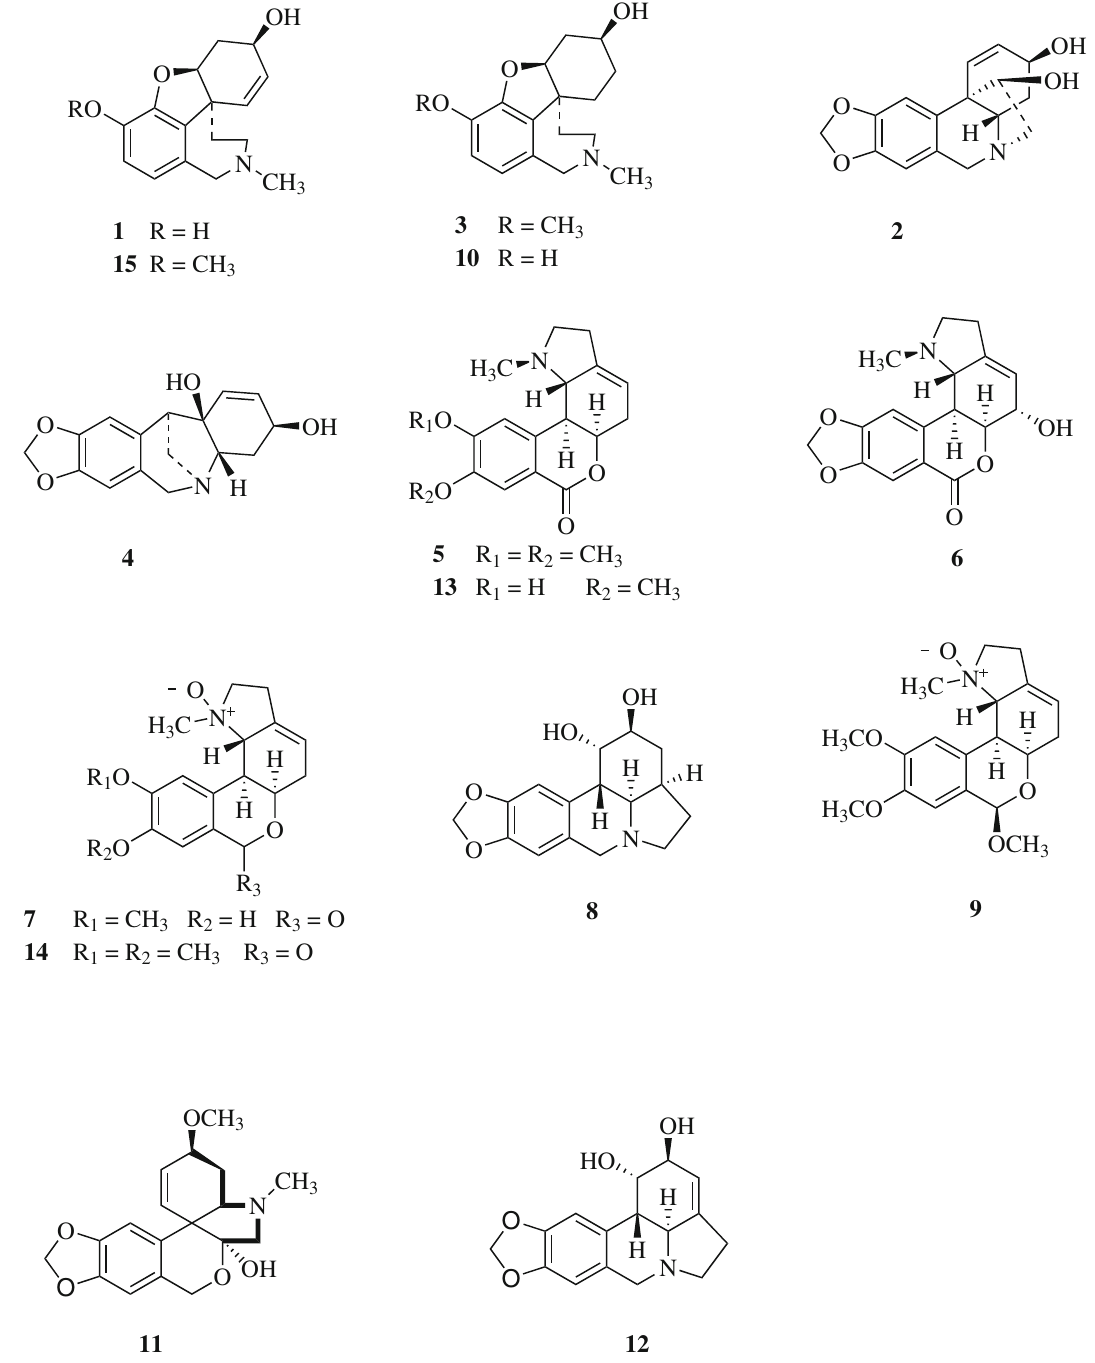
Fig. 1 Structures of Compounds 1–15 from Lycoris